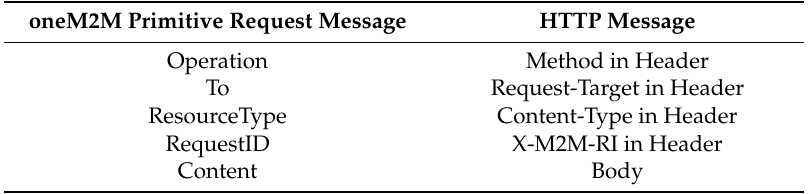
Table 1. Mapping between oneM2M primitive Request messages and HTTP messages.